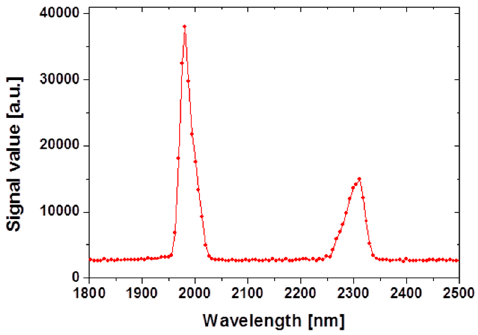
Figure 2. Optical spectra of the signal (1980 nm) and idler (2300 nm) waves from the OPO output.